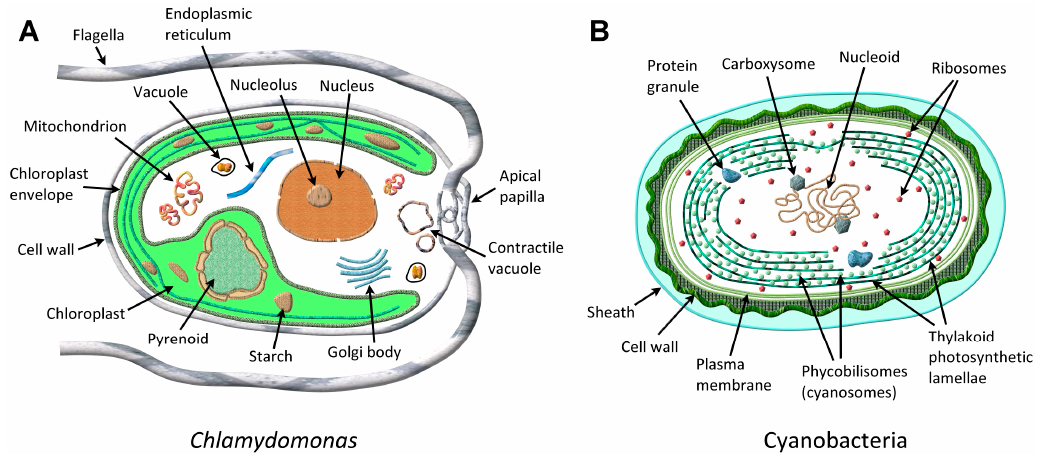
Figure 1. Schematic of the major components of eukaryotic ( A ) and prokaryotic ( B ) microalgal cells.